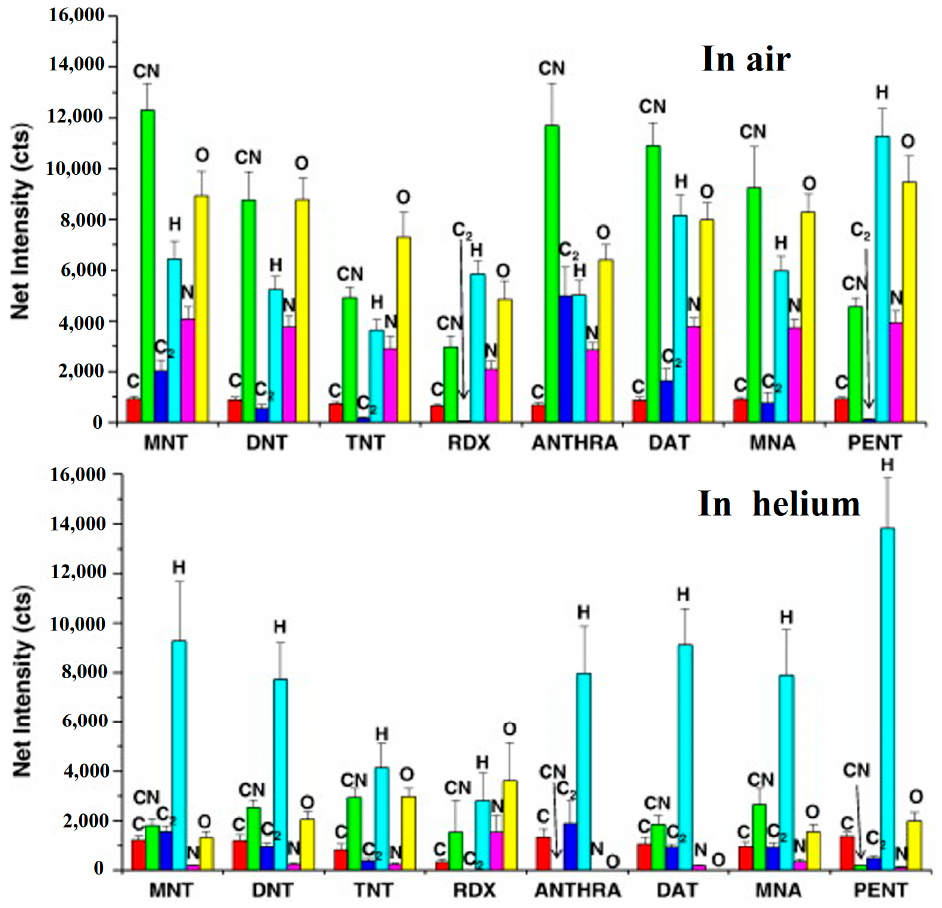
Figure 8. Net intensity of the LIBS signal in air and helium from several organic compounds. Adapted from [11], with permission from © 2011 Elsevier.